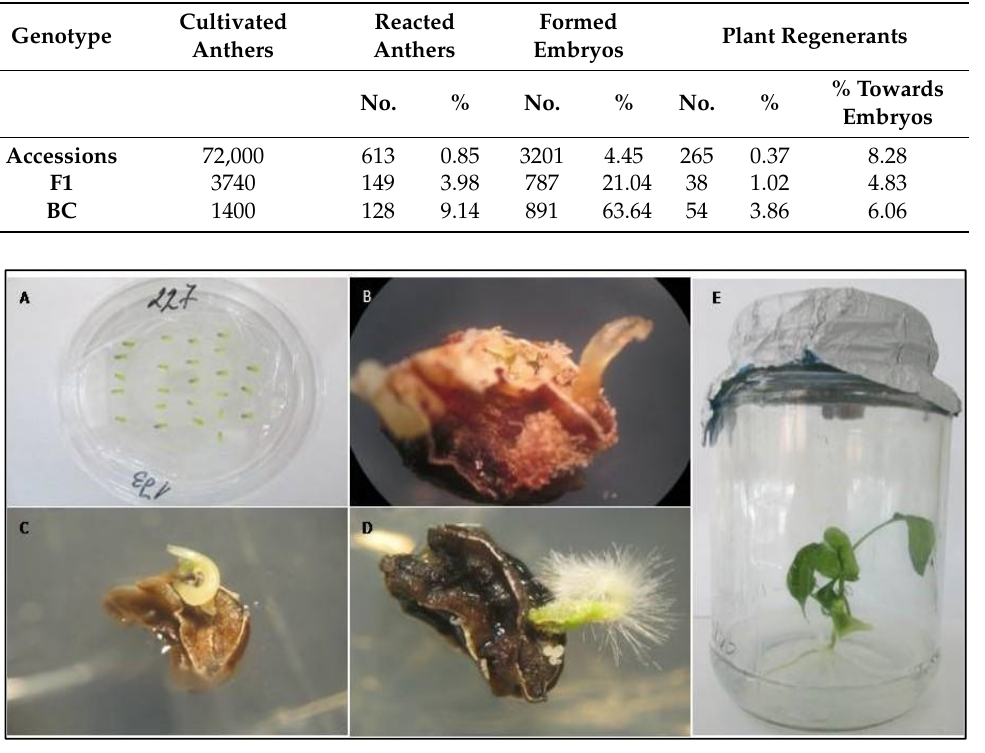
Figure 1. In vitro anther culture and plant regeneration. ( A ) Anther cultivation. ( B ) Induction of embryo formation. ( C ) Embryo development. ( D ) Embryo conversion. ( E ) Plant-regenerants. Table 1. Summarized results of androgenic response in 180 accessions, 4 F 1 , and 7 BC pepper proge- nies.